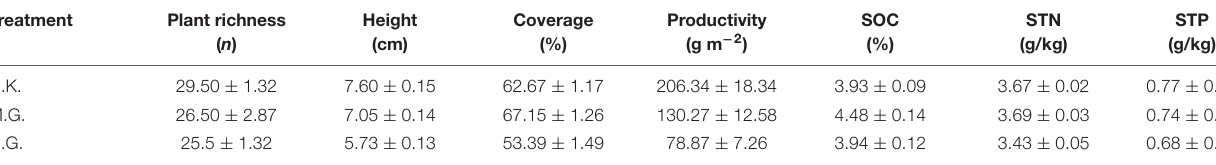
TABLE 1 | Information on grazing plot and nutrient on the Kuixin Valley of Linzhou